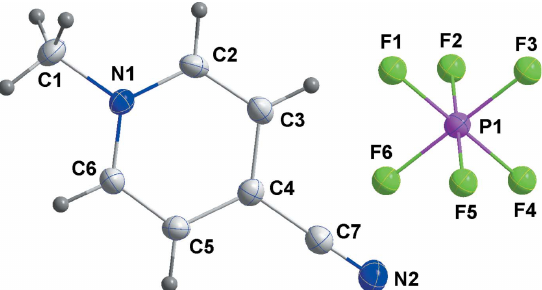
Figure 1 Perspective view of 1 with labeling scheme and 50% probability ellipsoids.